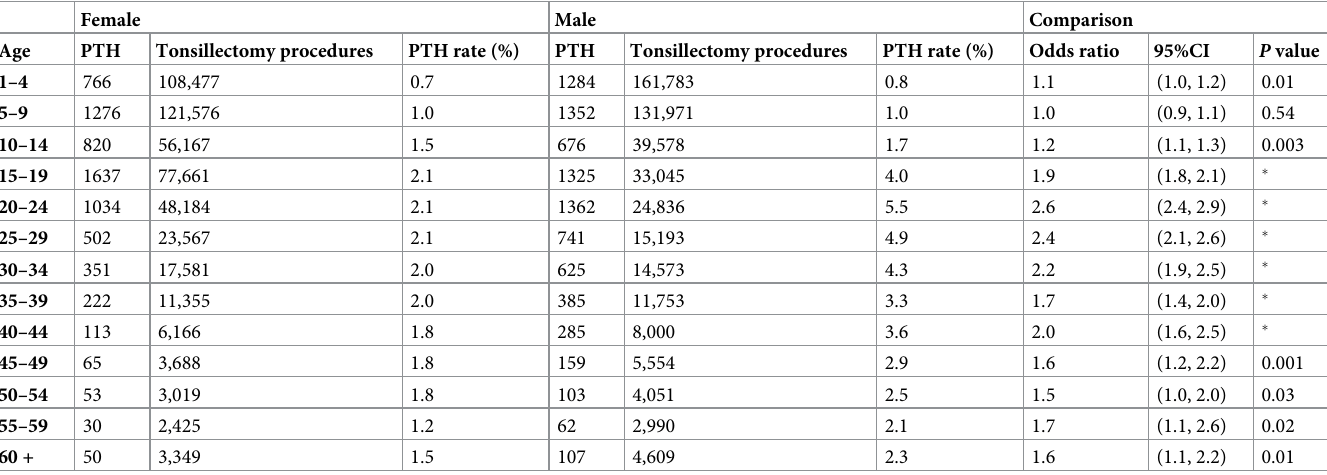
Table 2. Comparison of age-specific post-tonsillectomy haemorrhage rates between the male and female gender. Female Male